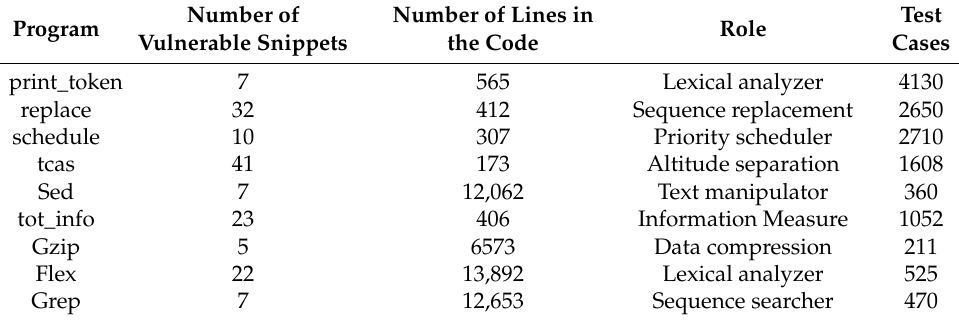
Table 4. Table representing the subject programs for